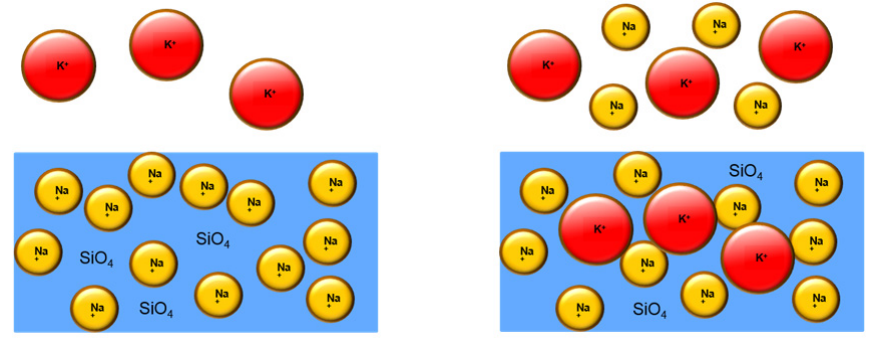
Fig. 3 Chemical treatment – Ionic Exchange.